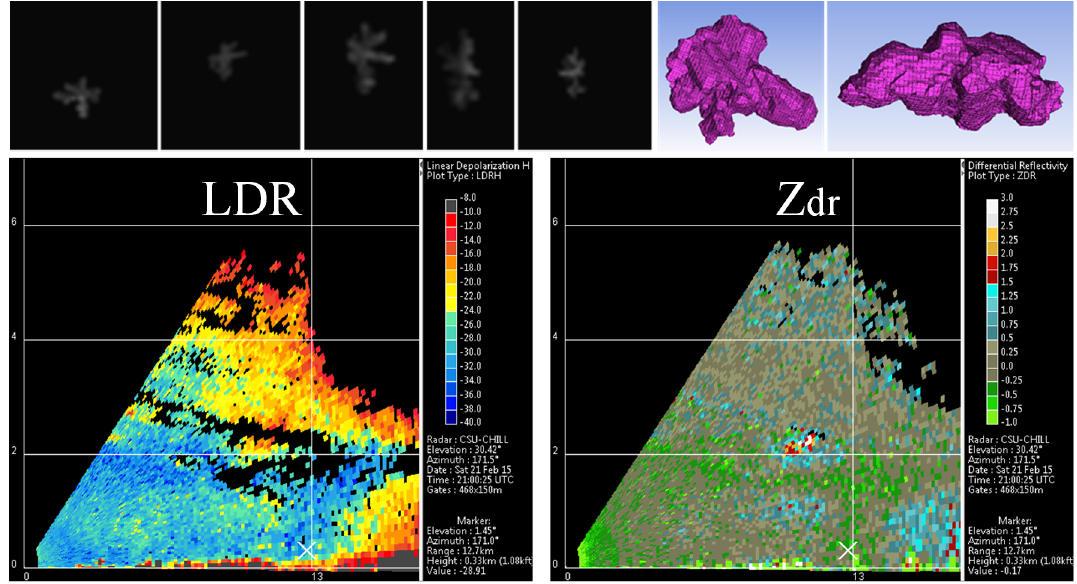
Figure 32. Illustrative results of MoM-SIE scattering calculations based on the MASC images captured at the MASCRAD Field Site during the major snow band passage event on 21 February 2015 and the resulting 3D shape reconstruction, in comparison with the corresponding CSU-CHILL radar RHI plots of LDR and Z dr at the same time. Results: MASC/MoM-SIE: ε r = 1.216 − j0.0002, LDR = − 31 dB, Z dr = − 0.1 dB; CHILL Radar: LDR = − 29 dB, Z dr = − 0.17 dB, at the 12.92-km range.